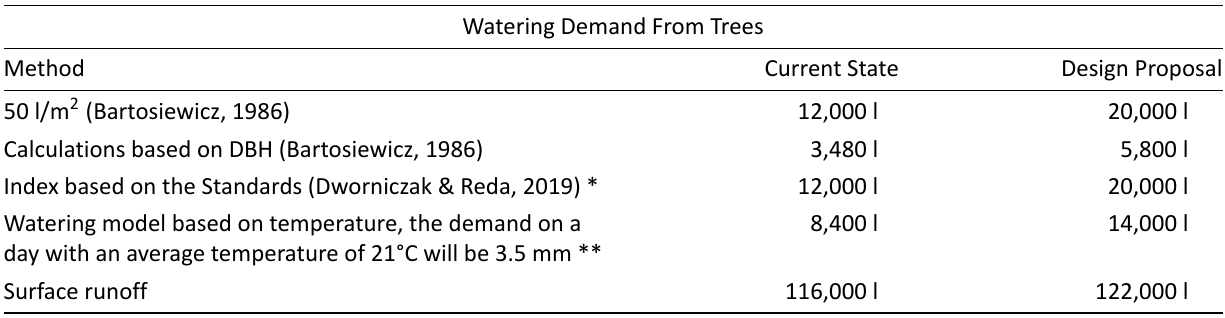
Table 6. Old Market Square, Lodz: Calculations of water demand from trees in the current state and in the design proposal. Watering Demand From